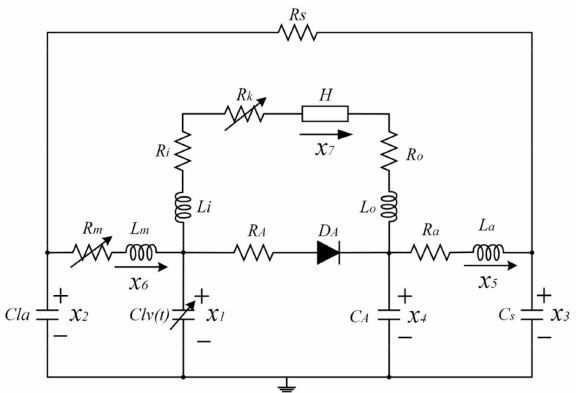
Figure 1. Equivalent circuit model of the LVAD-cardiovascular system.